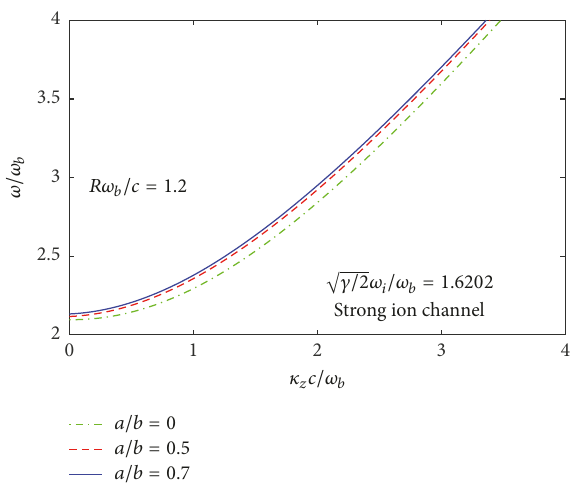
Figure 12: The effect of the ratio 𝑏/𝑅 on the dispersion curves of the TM modes for strong and weak ion channel with 𝛾 = 4 . The inner radius of the annular beam is taken as 𝑎 = 0.1𝑅 .